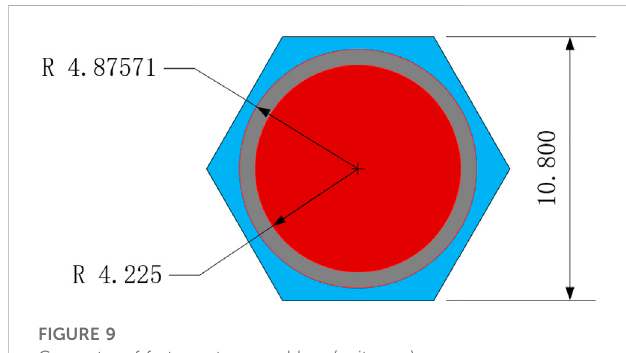
Geometry of fast spectrum problem (unit: mm).